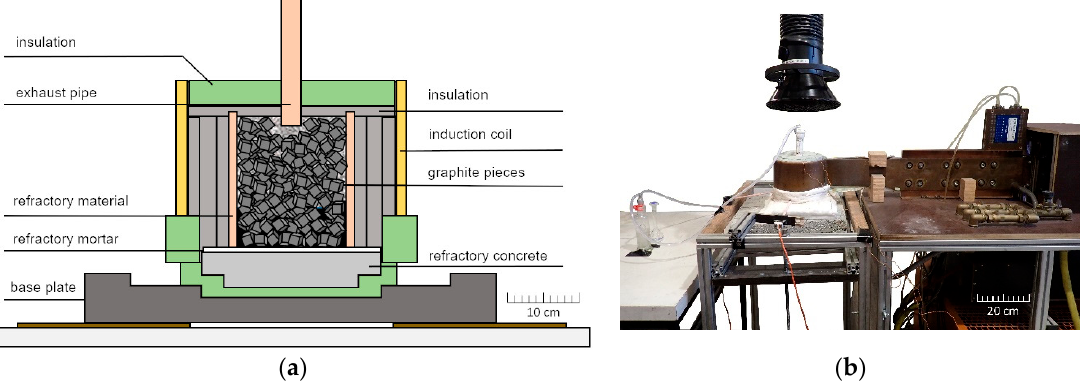
Figure 3. ( a ) Schematic representation of the original InduMelt plant (Design 1) [34]; ( b ) overall setup in test operation.